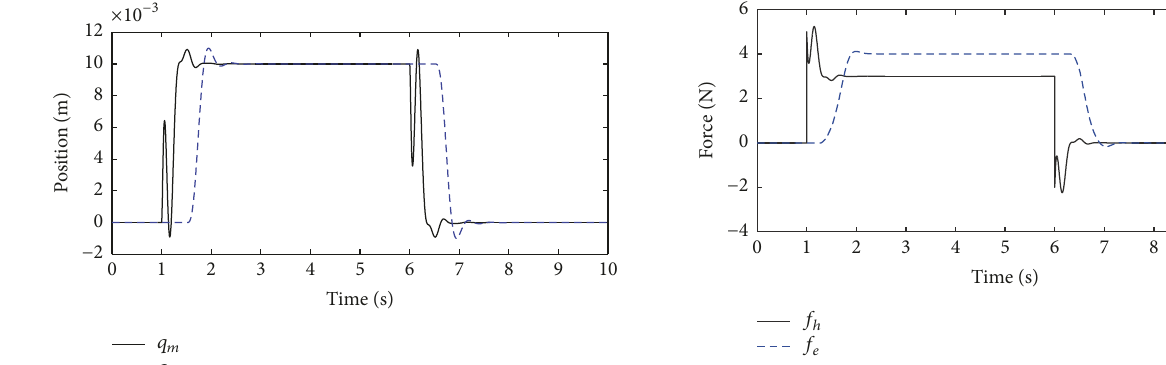
Figure 16: Force tracking performance ( 𝑇 𝑖 (𝑡) = |𝑋 𝑖 (𝑡)| (𝑖 = 1, 2),𝑋 ∼ 𝑁(0.4, 0.01) 𝑖